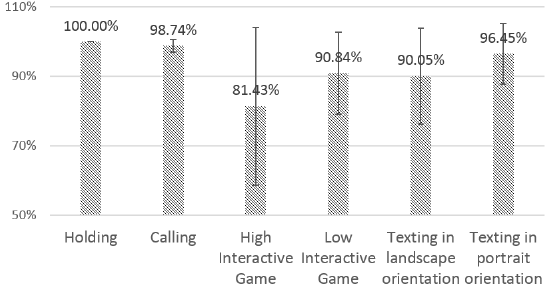
Figure 7. Average QRS peak detection ratios (PDRs) and SD for different use cases.